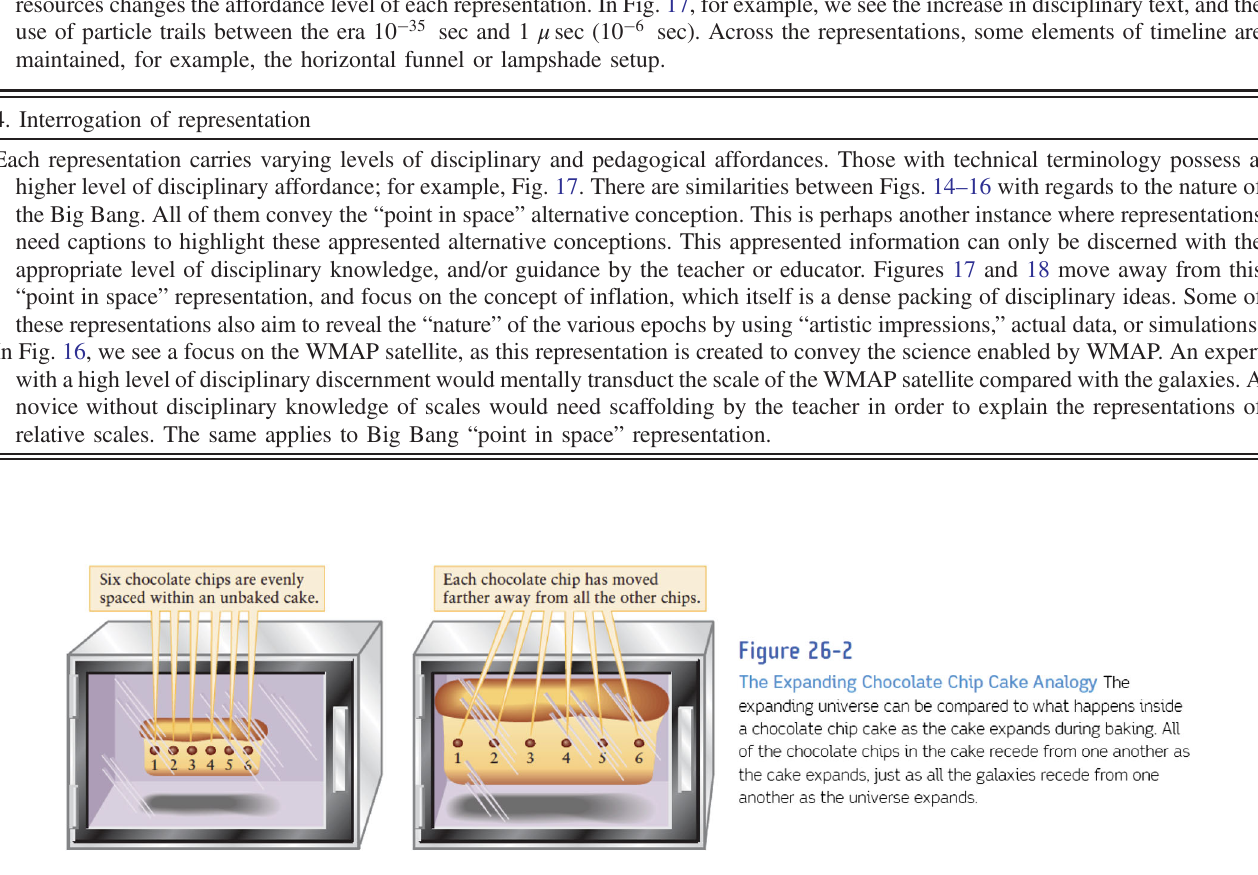
FIG. 19. The expanding Universe representational analogy using chocolate chip cake. Freedman, Geller and Kaufmann [101]. Used with